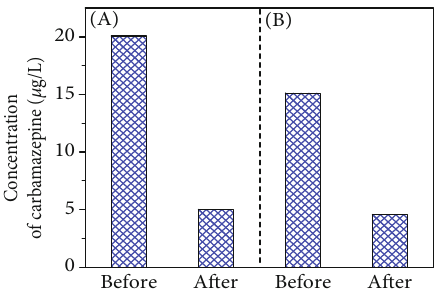
Figure 2: Removal e ffi ciency of carbamazepine on MFX: (a) domestic sewage and (b) secondary sedimentation tank e ffl uent.